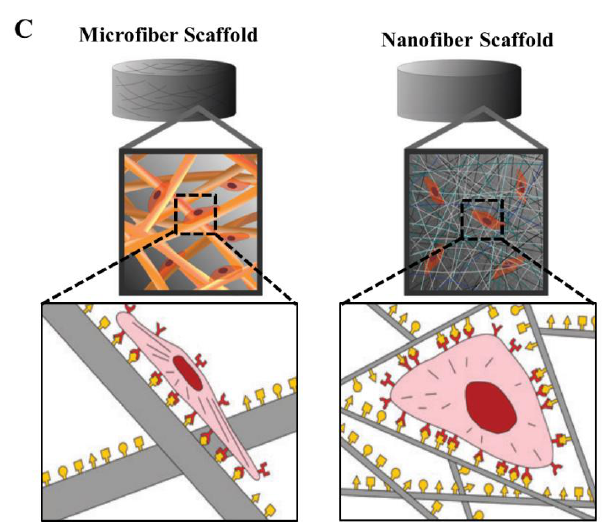
Figure 4. ( A ) Electrospinning setup and optimisation parameters. ( B ) Electrospun nanofiber. ( C ) Schematic showing the nano scale interaction with the cell. Reproduced with permission of [78].